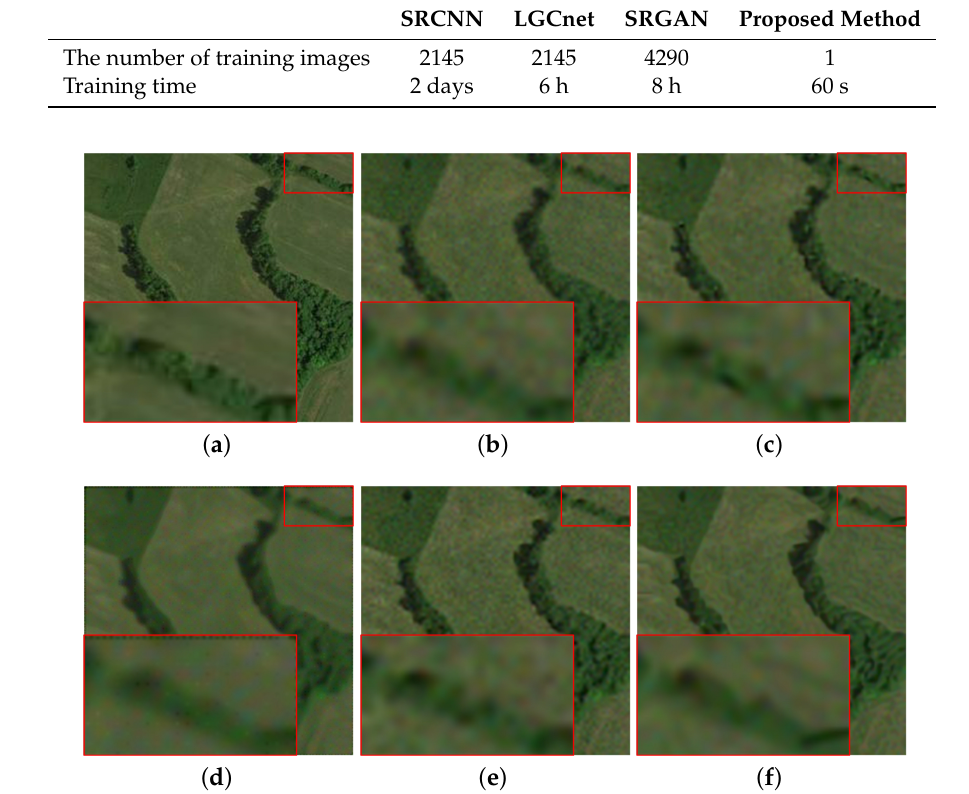
Table 5. Comparison for the number of training images and training time.